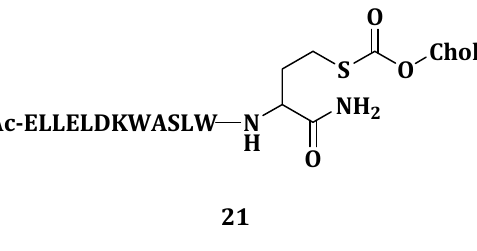
Figure 9. Structure of ELLELDKWASLW-Chol ( 21 ). Table 5. Sequence and antiviral potency of C34-Chol and controls against